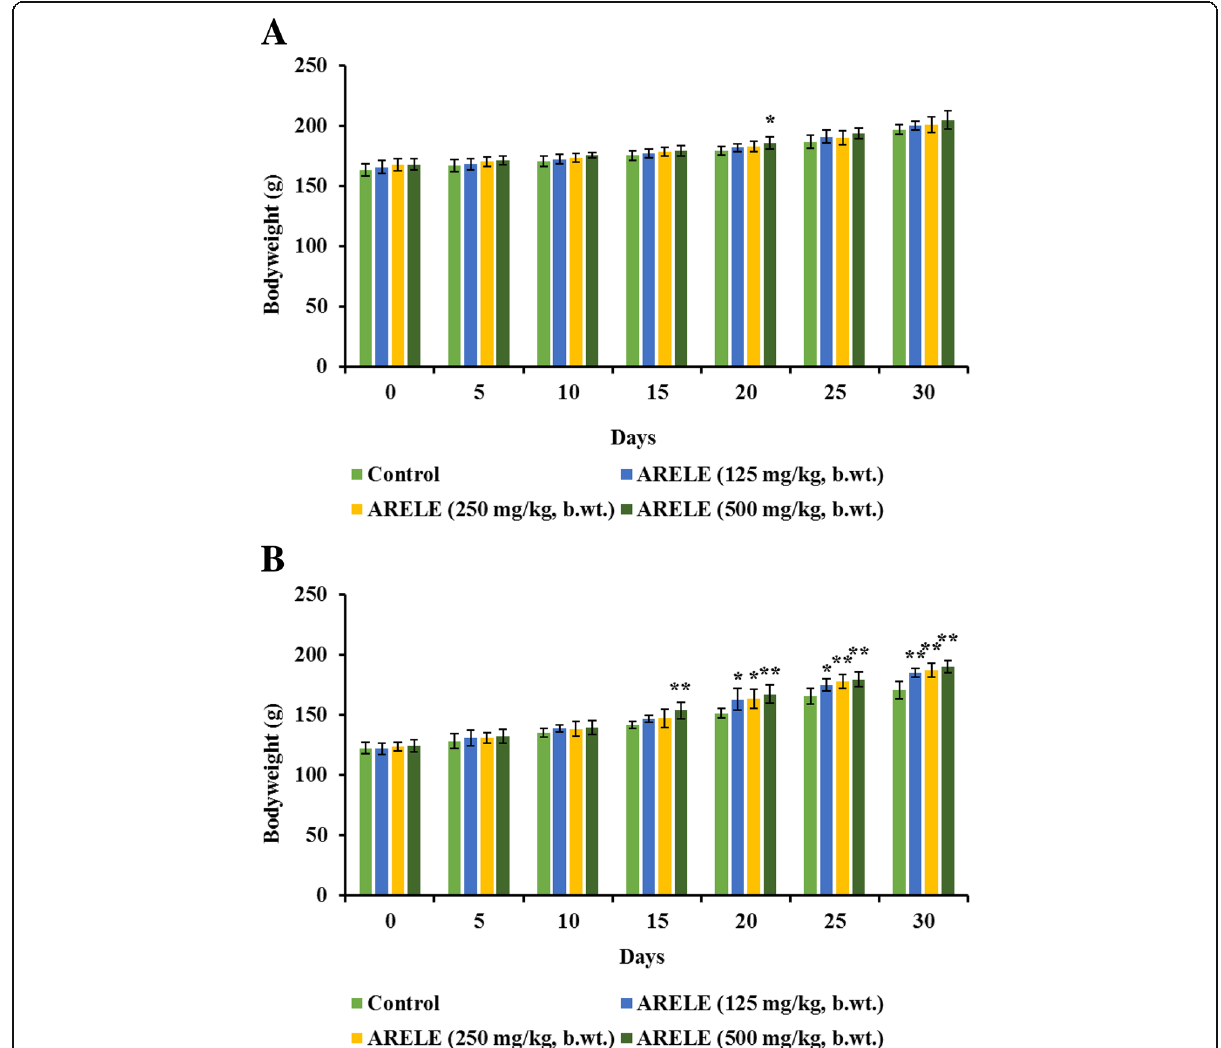
Fig. 1 Effects on body weight of rats after treatment with ARELE at different doses for a period of 30 days. a Male rats. b Female rats. Values are expressed as mean ± S.D. ( n = 6). Statistical analysis done by one-way ANOVA followed by Dunnet ’ s t-test. ** P < 0.01 compared to control group. * P < 0.05 compared to control